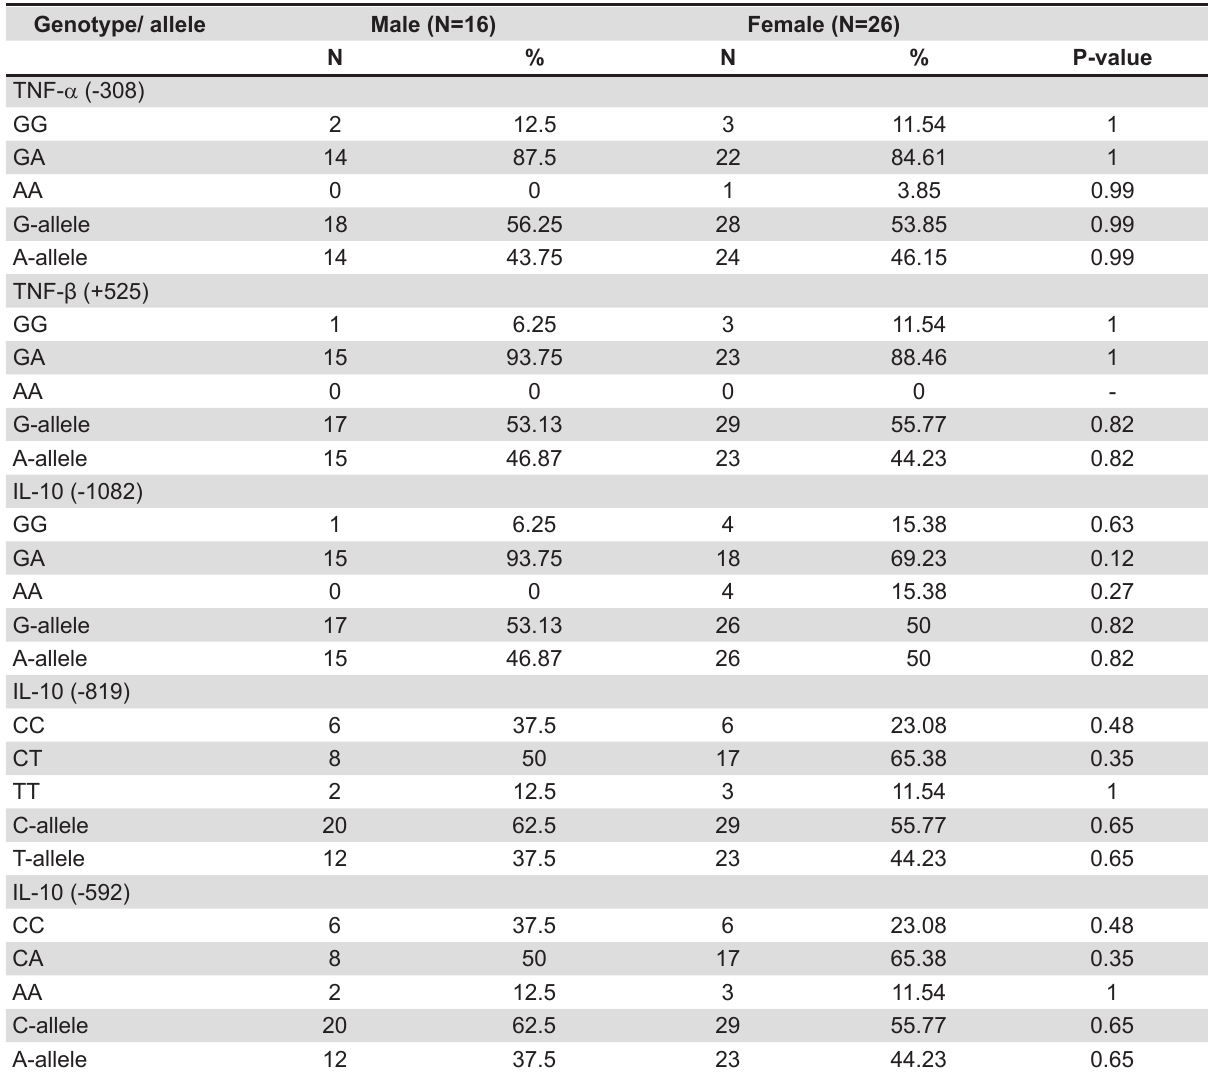
Table 4- Genotype and allele frequencies in male and female oral lichen planus